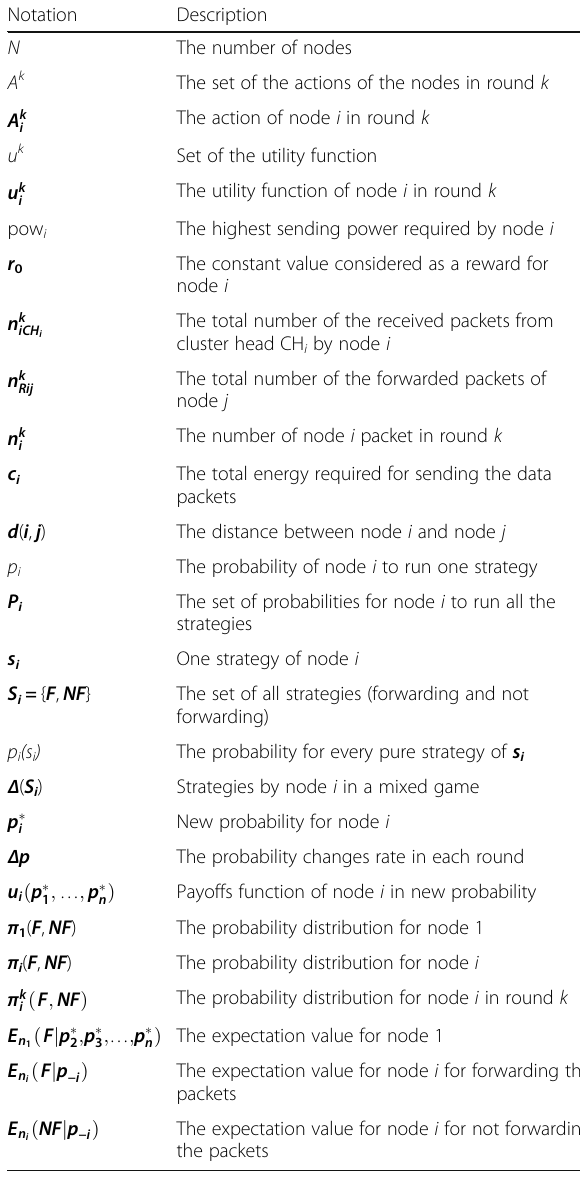
Table 2 Notations and its description of